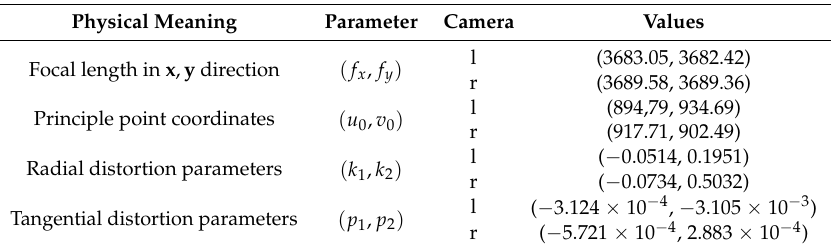
Table 2. Intrinsic parameters of the left and right cameras.